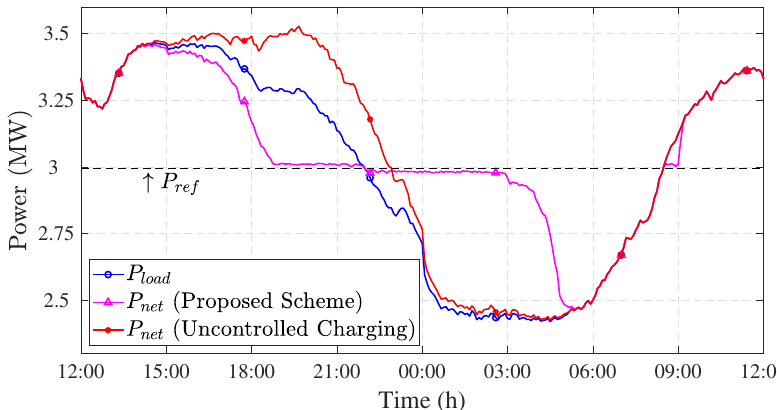
Figure 5. Net load profile of IEEE 13-node distribution feeder.